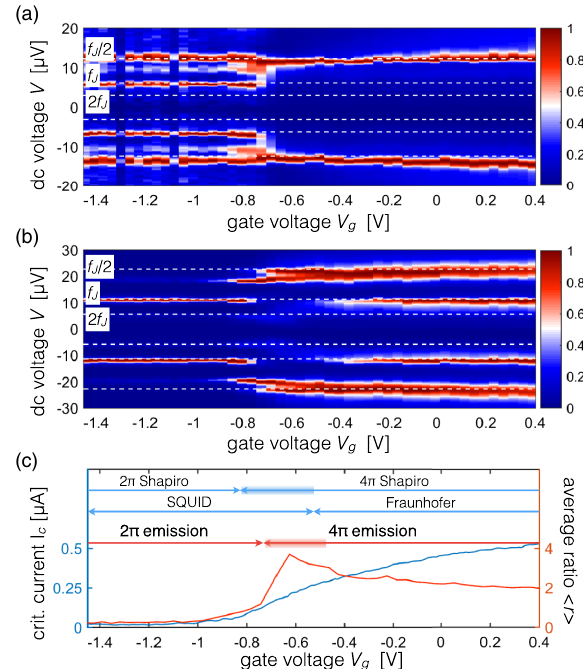
FIG. 4. Gate dependence. (a),(b) 2D maps of the normalized amplitude A as a function of bias voltage V and gate voltage V ¼ 2 . 98 and 5.5 GHz, respectively. In (b), a detection frequency f d resonant feature in the electromagnetic environment is visible as a ¼ − 0 . 5 and − 0 . 8 V, whose position is split peak between V g altered by the changein V (see Sec. IIIof SM [16]). (c)The ratio of g the intensity of the 4 π - to the 2 π -periodic amplitudes h r i ¼ h A i (averaged over frequency in the 2 – 10 GHZ range) 4 π =A 2 π (as a red line) and the critical current (as a blue line) are plotted as a function of gate voltage V . After rescaling of the critical current g measured in Ref. [18], the emission features can be compared with previous observations on the Shapiro